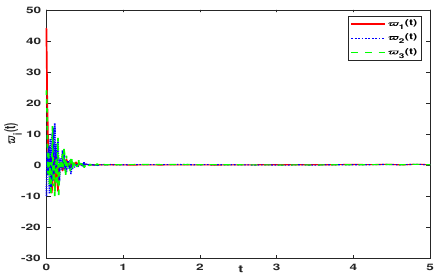
Figure 17. The error curves (cid:118) i ( t ) between the recovered signals and plaintext